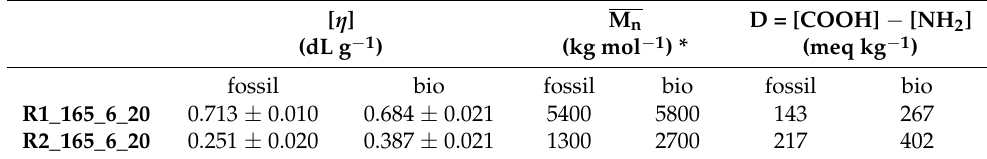
Table 5. Effect of reactor design: molecular size and end-group imbalance of R1 and R2 products. [ η ]